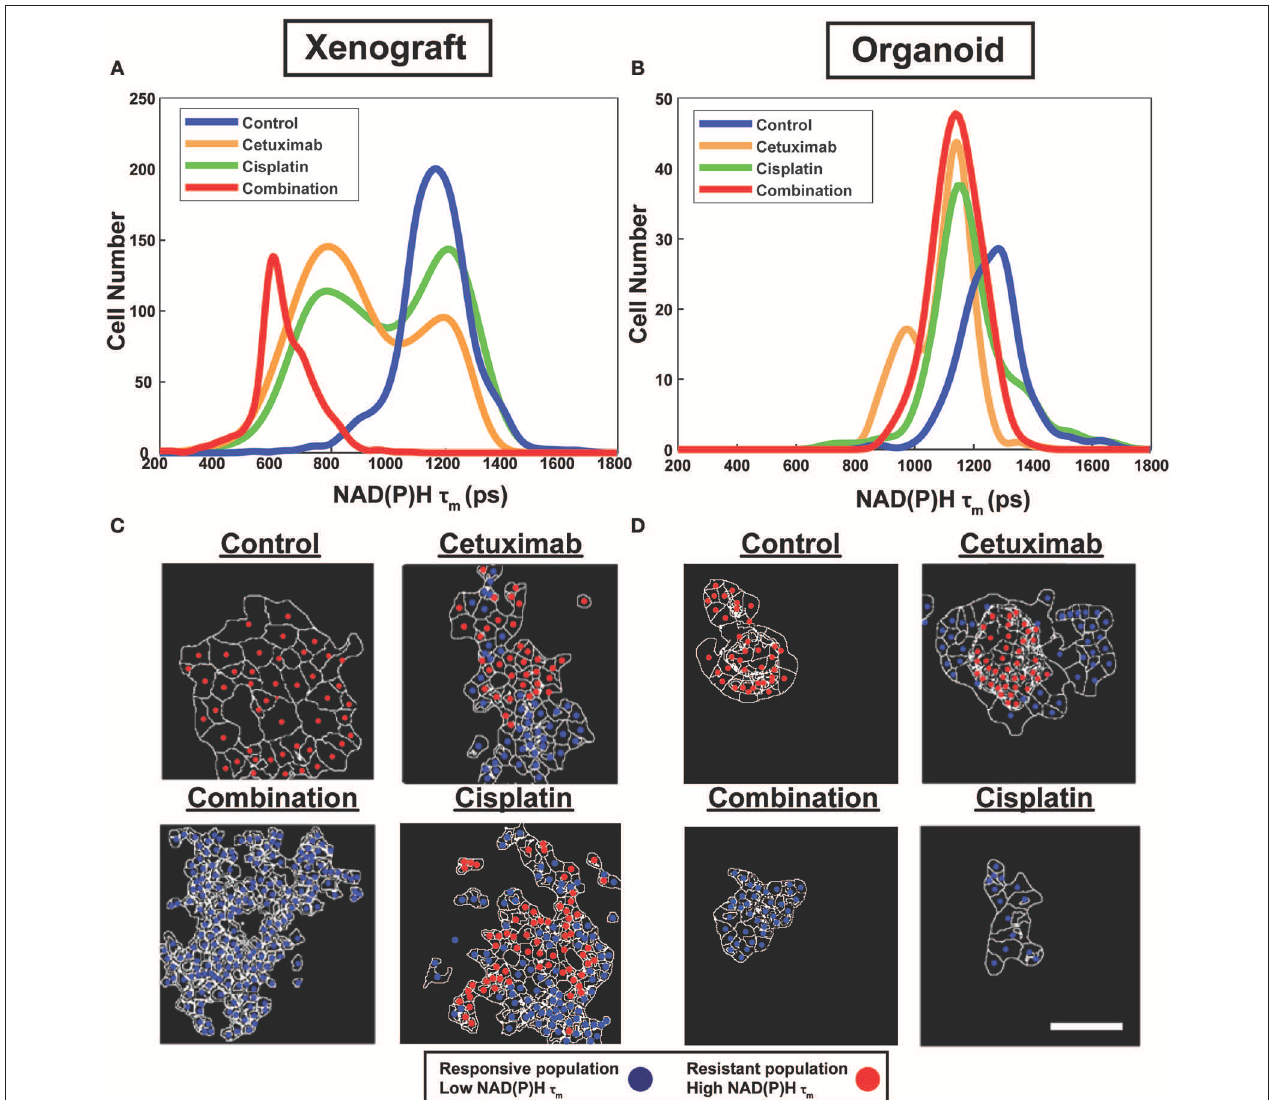
FIGURE 2 | Sub-population distributions and population mapping visualize treatment-dependent spatial heterogeneity within FaDu xenografts and organoids. Population density modeling of single cell measurements of NAD(P)H τ m in FaDu (A) xenografts and (B) organoids reveal heterogeneous cell populations within control, cetuximab-treated, cisplatin-treated, or cetuximab and cisplatin-treated (combination) groups. Representative population maps of control and treated (C) xenografts and (D) organoids demonstrate spatial organization of cell populations with differing treatment response. Individual cells are color-coded based on the population assignment determined from density-based clustering analysis. Responsive populations, corresponding to low NAD(P)H τ m , are coded red, and resistant populations, corresponding to high NAD(P)H τ m , are coded blue. Cell outlines are in white. Scale bar, 50 µ